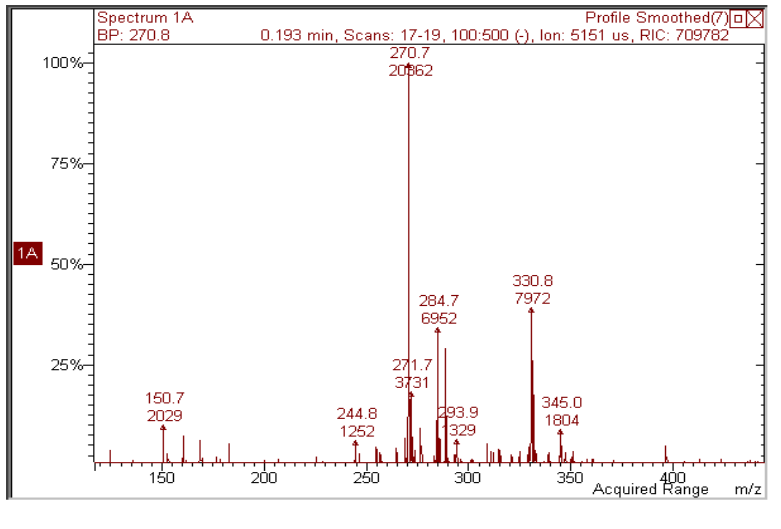
Figure 8. Negative-ion mass spectrum of a 2 × 10 − 5 M methanol solution of galangin irradiated with 70 J/cm 2